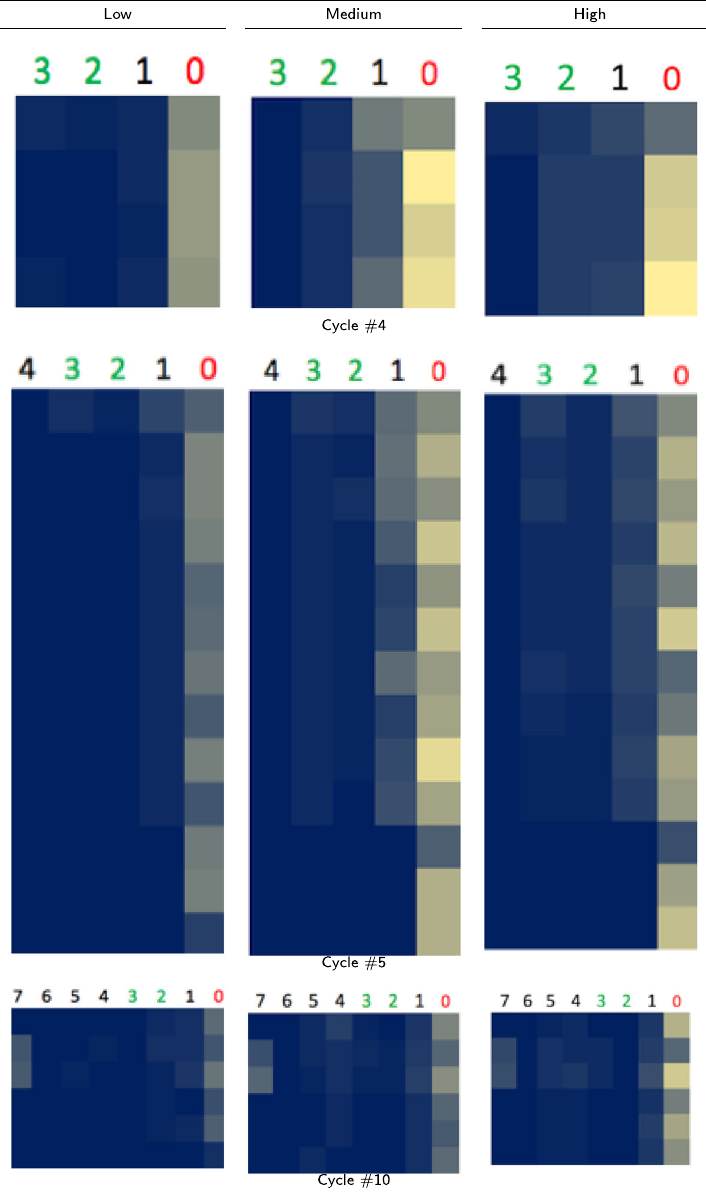
Table 3 Intensity chart for selected cycles categorized by students’ performing